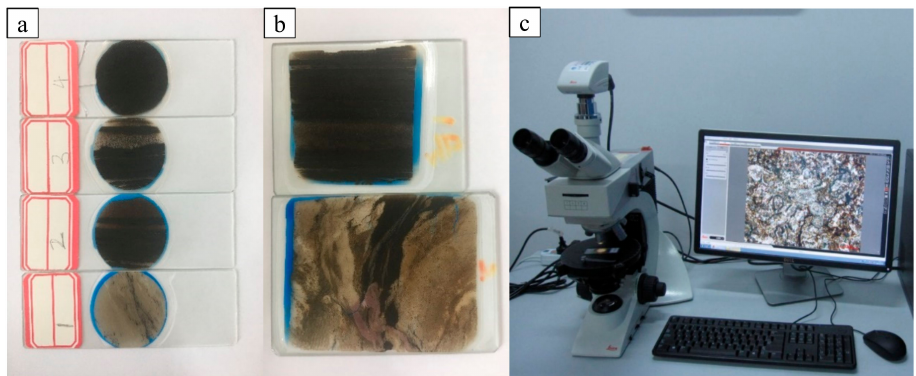
Figure 7. ( a ) slices of round rock castings with diameter of 2 cm; ( b ) the bigger square rock casting sheet can show the complete rock structure more clearly; ( c ) DM2700P microscope.